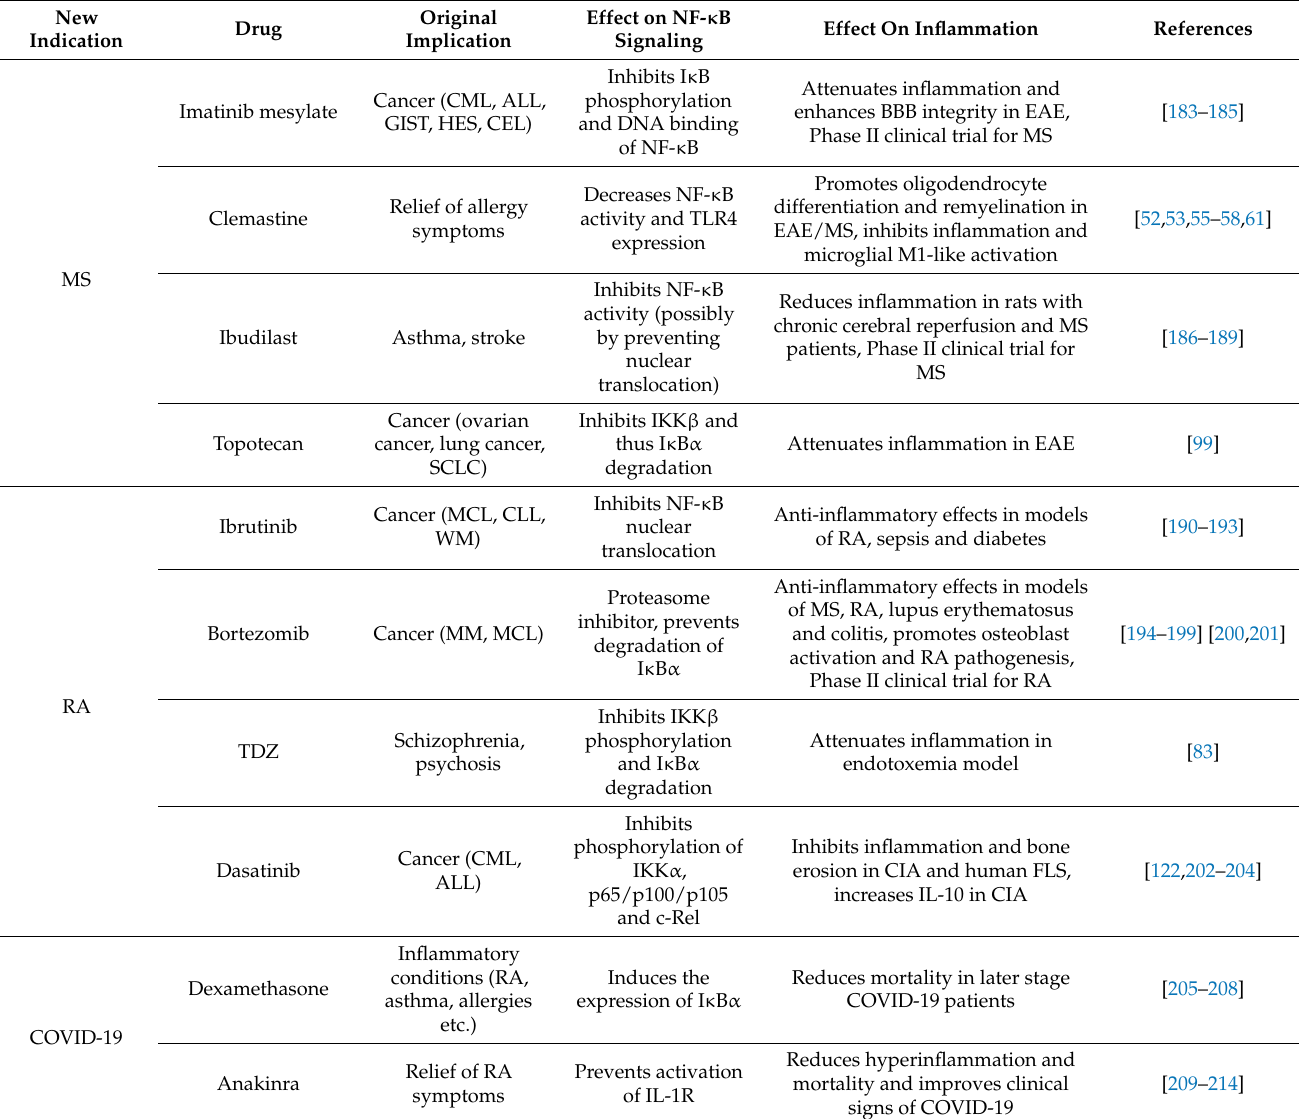
Table 5. Drug repurposing candidates for inflammatory diseases targeting NF- κ B